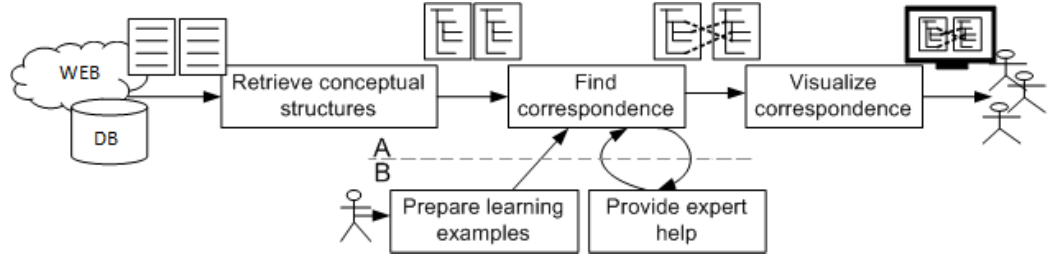
Figure 1. The dependence of information logistics on the method of conceptual correspondence